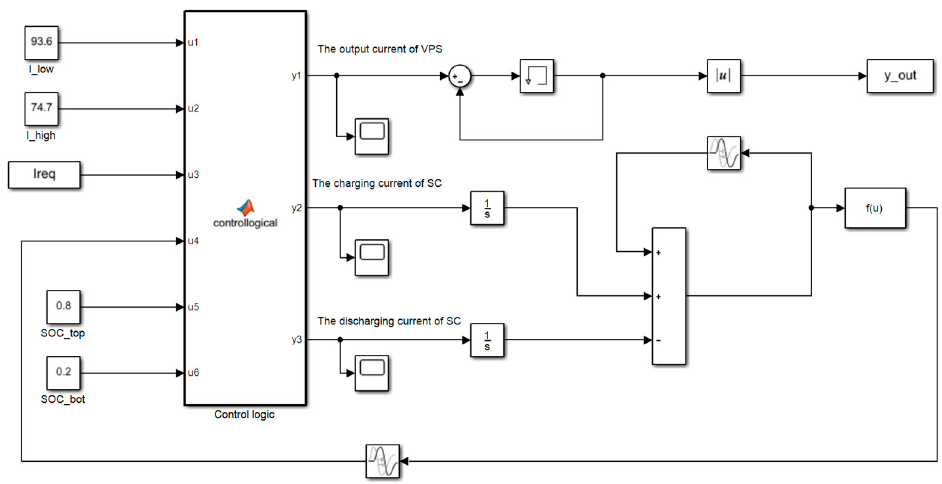
Figure 3. The fitness model of energy management strategy optimization.